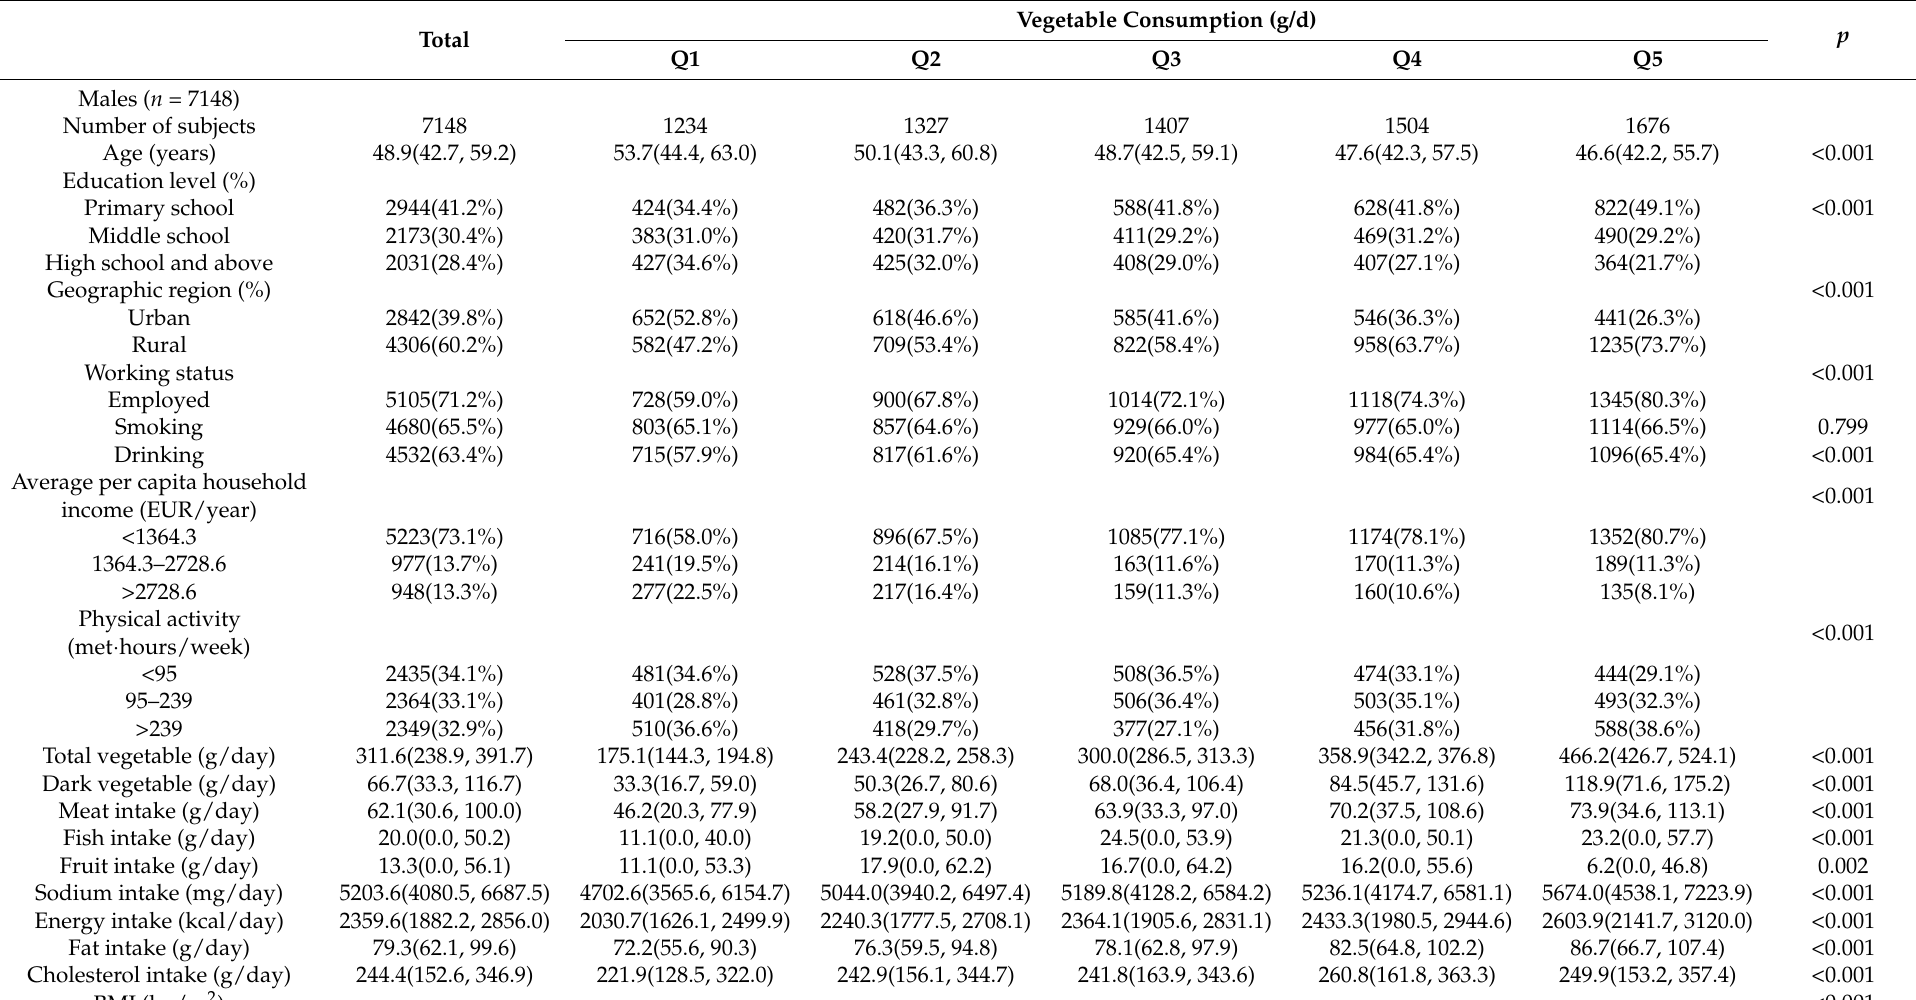
Table 1. Baseline characteristics of study subjects by vegetable consumption groups (CHNS study,